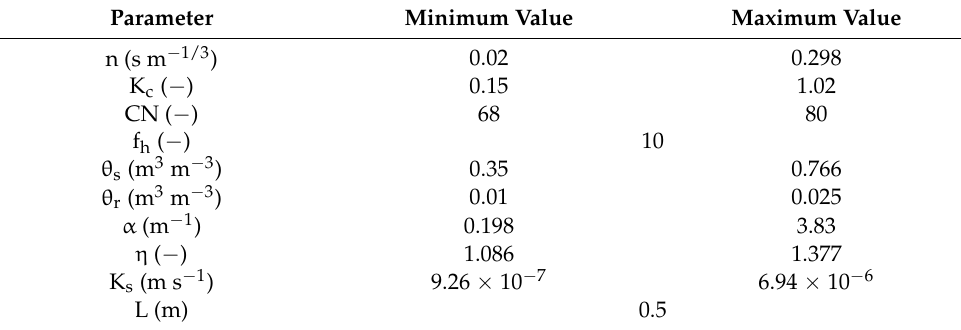
Table 2. Summary of calibrated parameters.